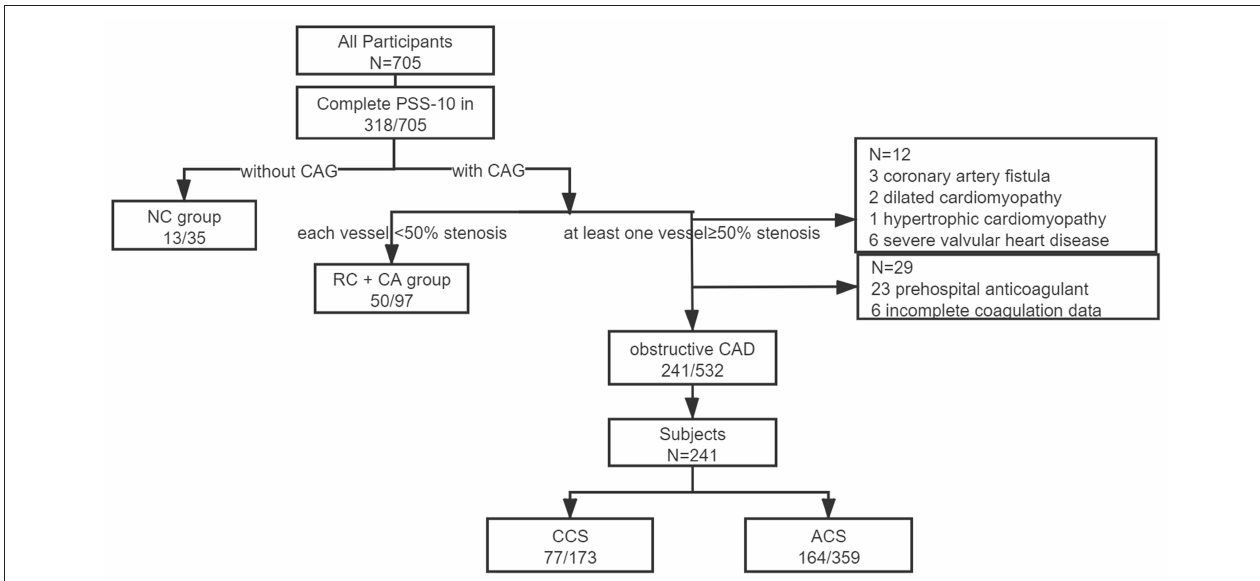
FIGURE 1 | Patient recruitment. Obstructive coronary artery disease (CAD) indicated with at least one obstructive vessel ( ≥ 50%) presented in coronary angiography during this hospitalization or with a history of coronary artery bypass grafting or coronary stent implantation. NC, without coronary angiography; RC, rule out of CAD; CA, coronary atherosclerosis; CCS, chronic coronary syndrome; ACS, acute coronary syndrome; and CAD, coronary artery